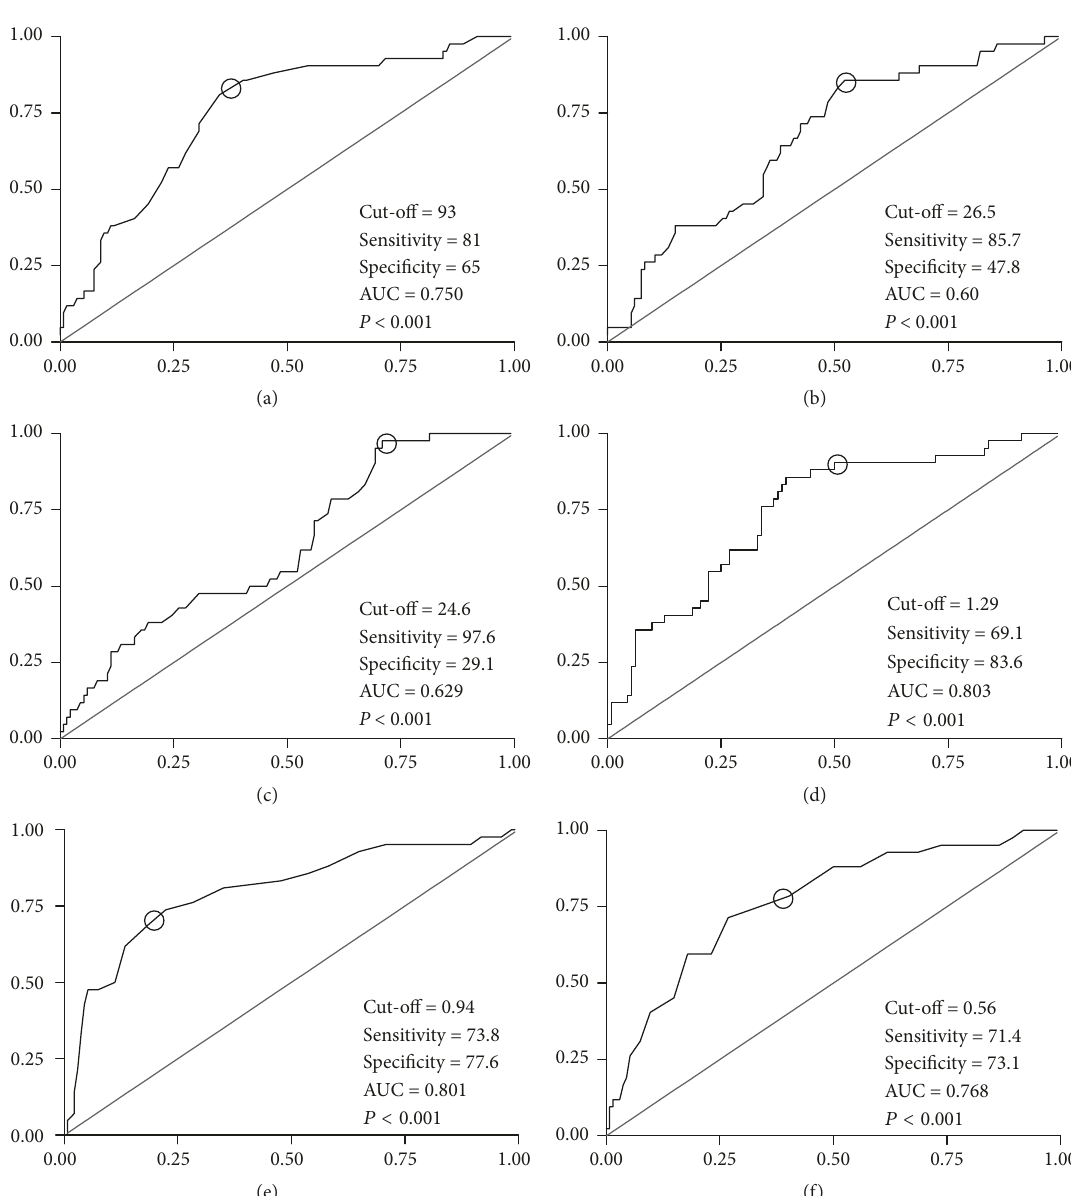
Figure 1: Receiver Operating Characteristic curve according to sensitivity (x-axis) and specificity (y-axis) of (a) waist circumference; (b) body mass index; (c) body adiposity index; (d) conicity index; (e) waist-to-hip ratio; (f) waist-to-stature ratio, in men. AUC: area under the curve.